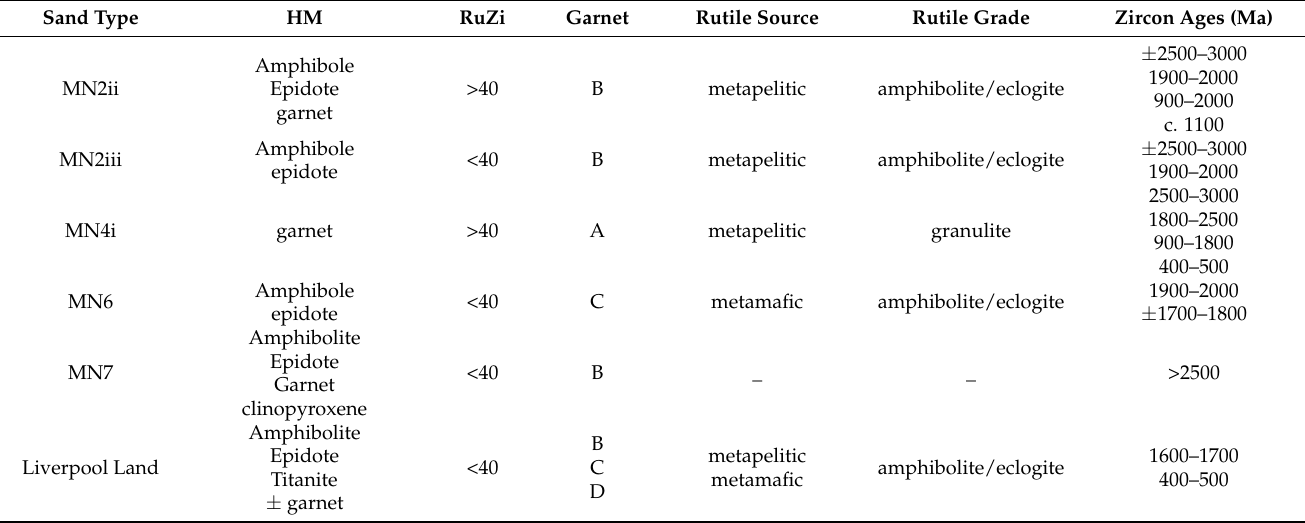
Table 2. The key distinguishing features of the identified sand types in the East Greenland moraine/outwash samples. Some zircon age ranges are not always present (indicated by ± in the